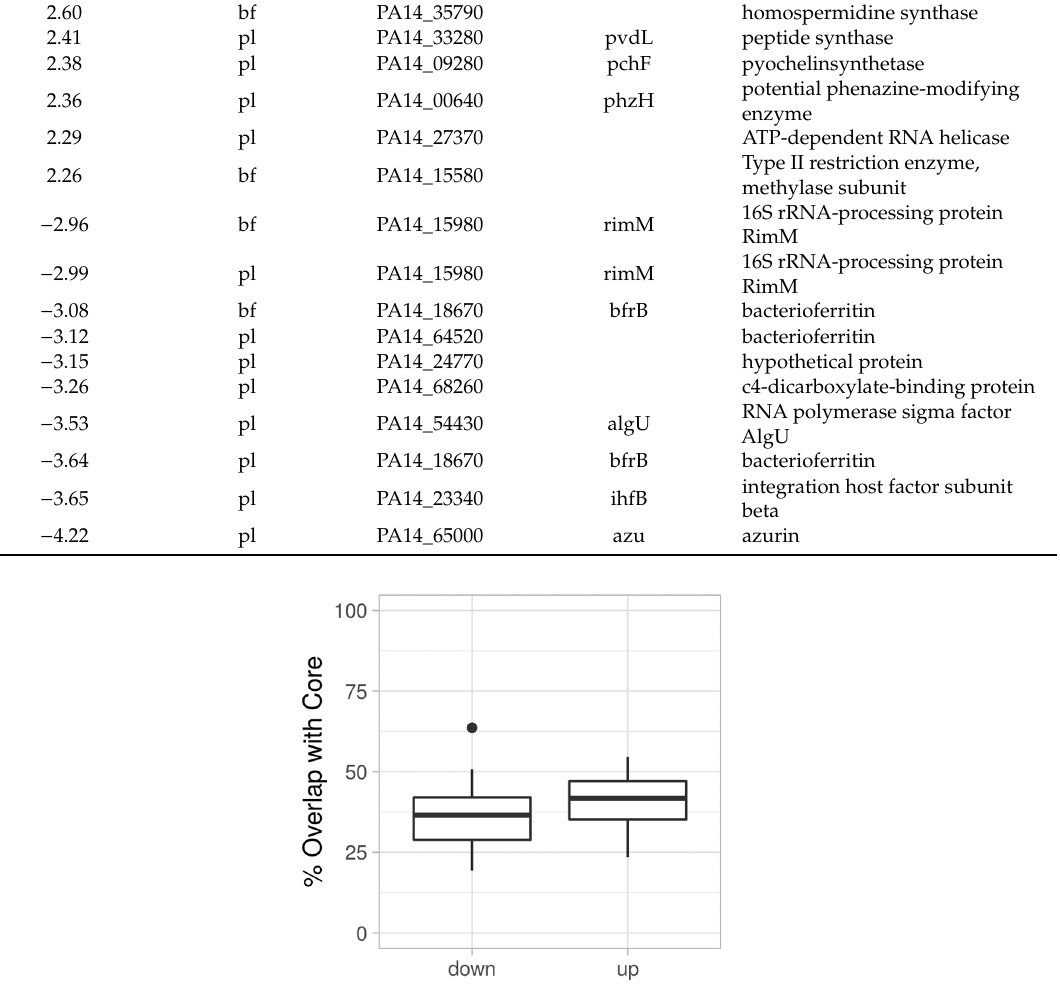
Figure A1. Overlap with core biofilm proteome for each strain.Percentage of significantly regulated proteins between a biofilm and planktonic condition that are also part of the core biofilm proteome. Data is divided into up-regulated (up) and down-regulated (down) proteins.